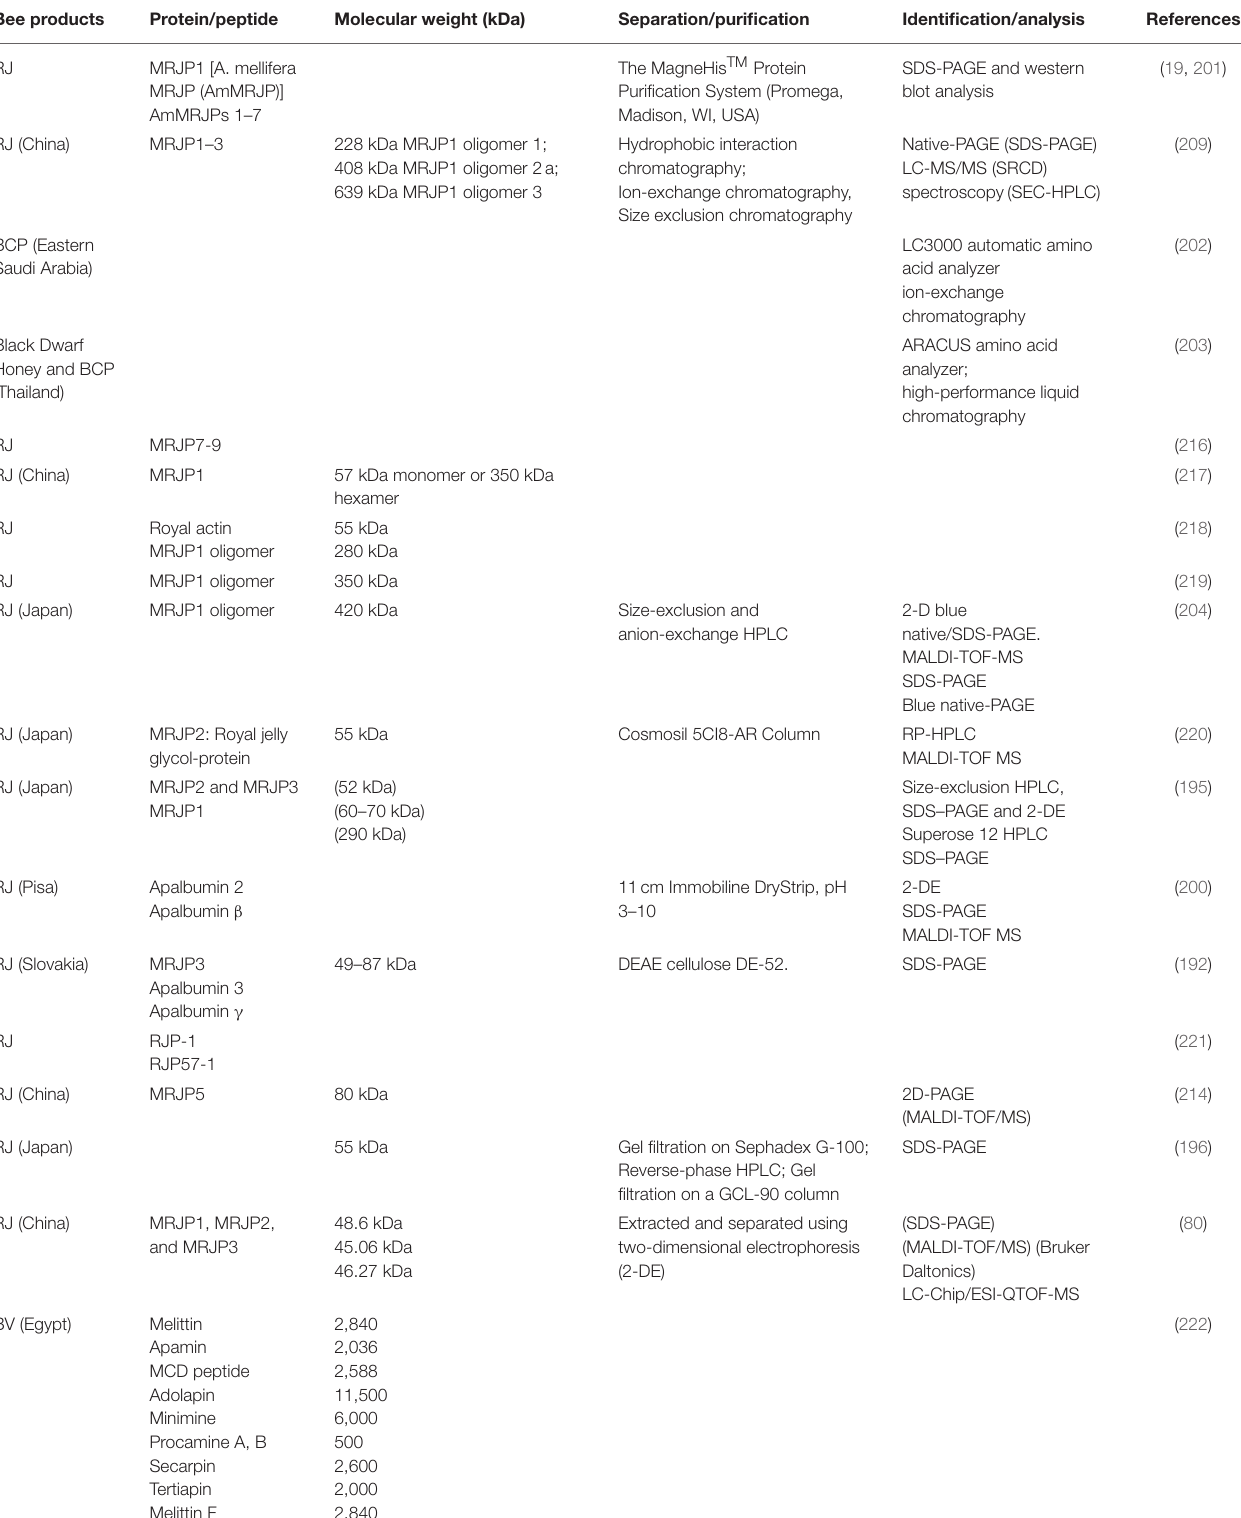
TABLE 5 | Purification and identification of the peptides from bee products. Bee